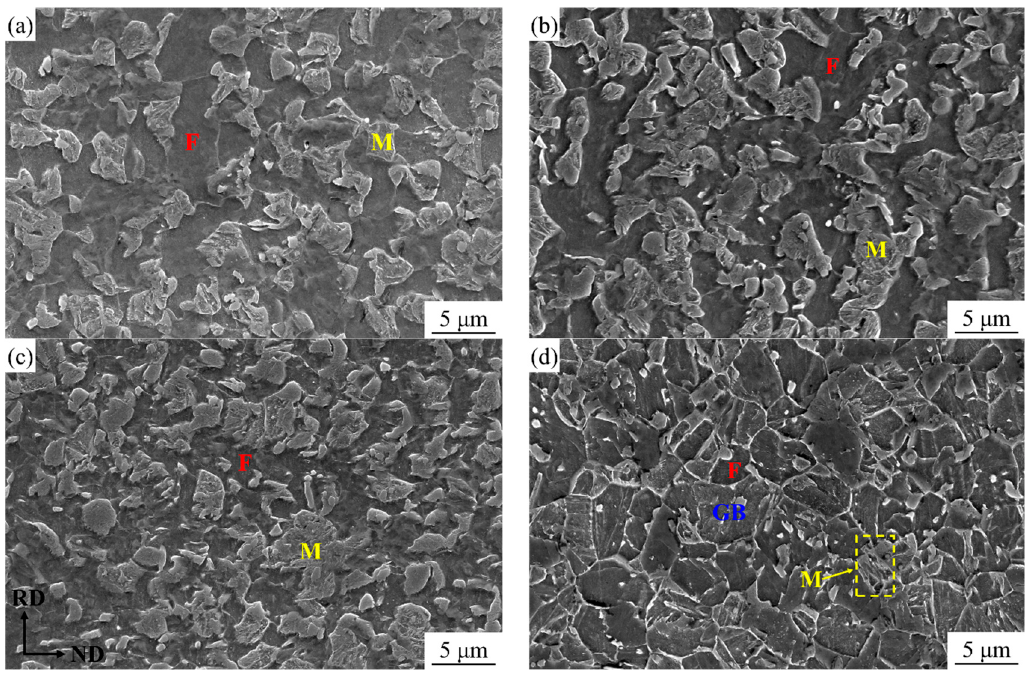
Figure 5. The microstructure of LH800 steel held at different temperatures for 15 min followed by air quenching: ( a ) 750 °C; ( b ) 775 °C; ( c ) 800 °C; ( d ) 825 °C. F: ferrite; M: martensite; GB: granular bainite; RD: rolling direction; ND: normal direction.